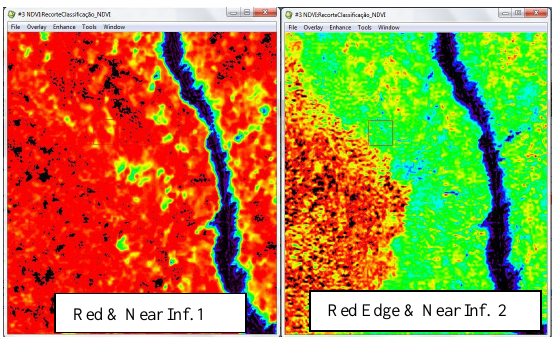
Figure 6: NDVI images from area under study: (A) Semi- evergreen Tropical forest, (B)